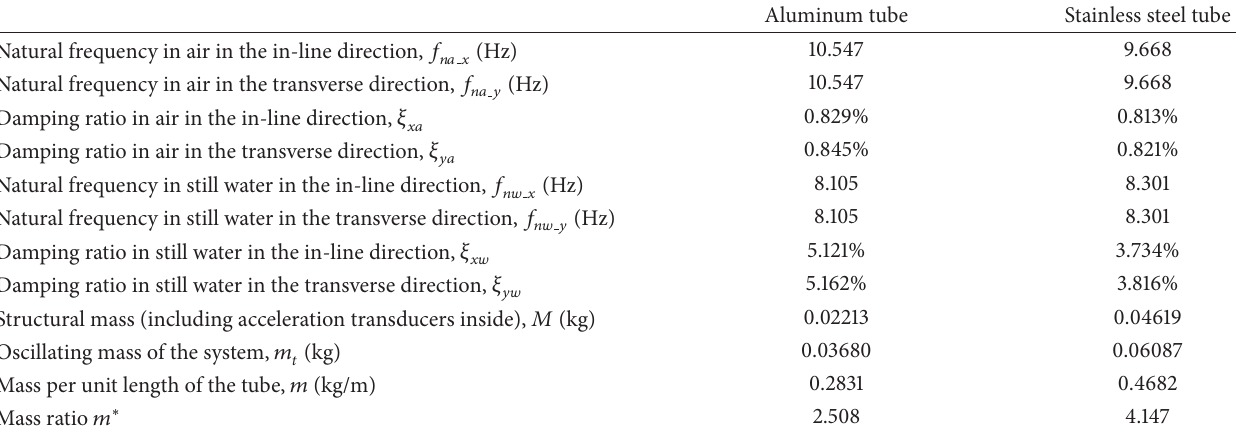
Table 1: Monitored tubes data without